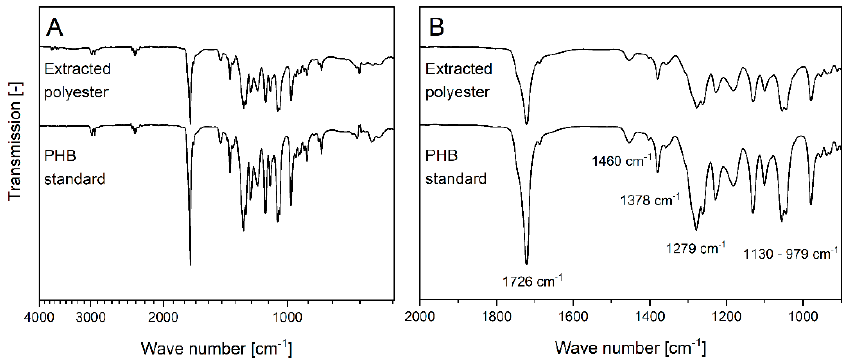
Figure 4. FTIR spectrum of PHB extracted from Leptolyngbya sp. NIVA-CYA 255 and PHB standard ( A ). A zoom into wave numbers ranging from 2000 to 800 cm − 1 ( B ).